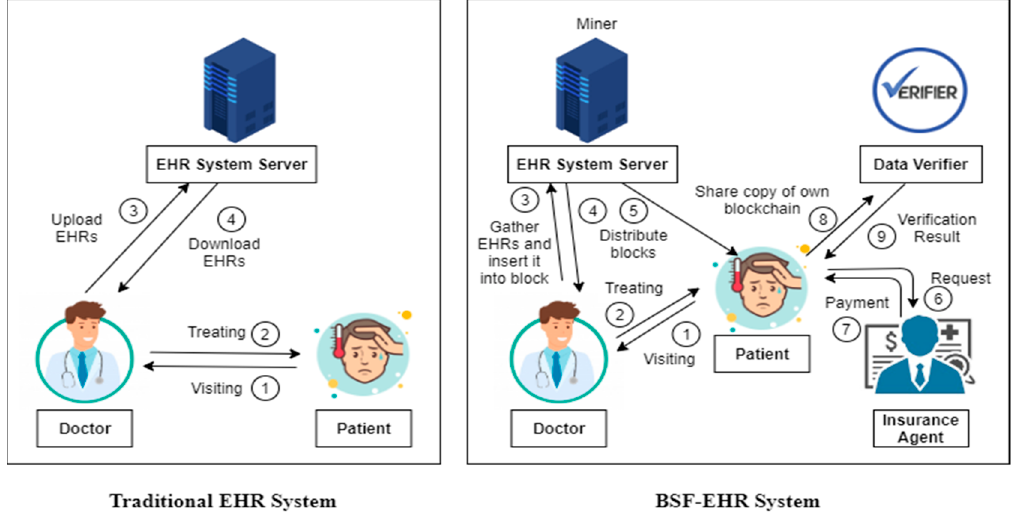
Figure 1. Novelty of BSF-EHR system.